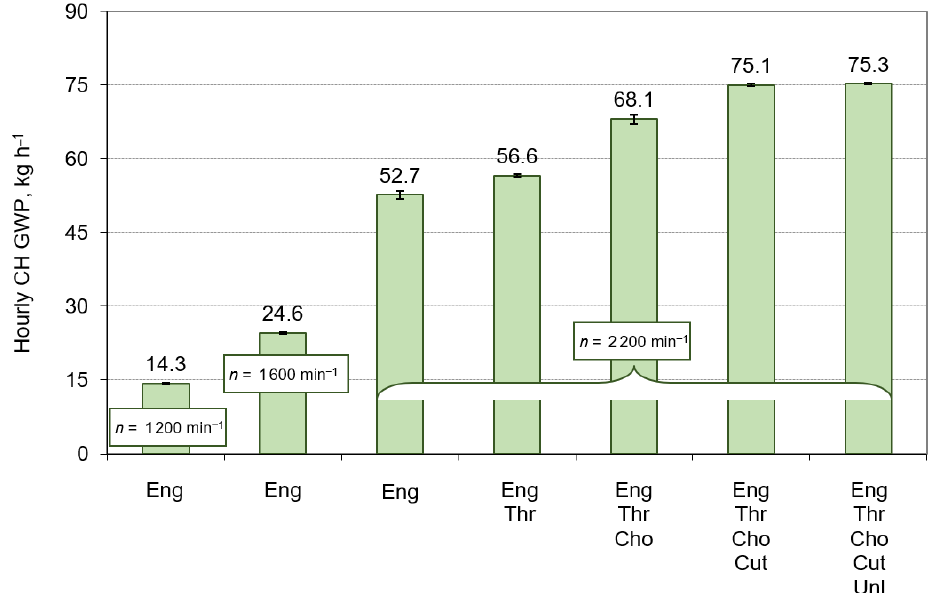
Figure 1. Hourly global warming potential (GWP) of a combine harvester (CH) in idle mode engaging different operational units (Eng = engine, Thr = threshing unit, Cho = straw chopper unit, Cut = cutter bar unit, and Unl = grain unloading unit, where n = engine crankshaft speed) in the 2019 tests. The value of each column is derived from an average of 20 replicates.